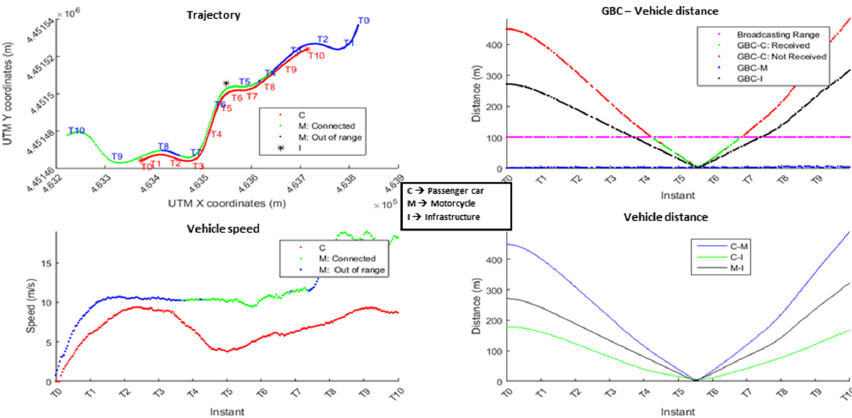
Figure 9. Results of Test 1 with RSU.